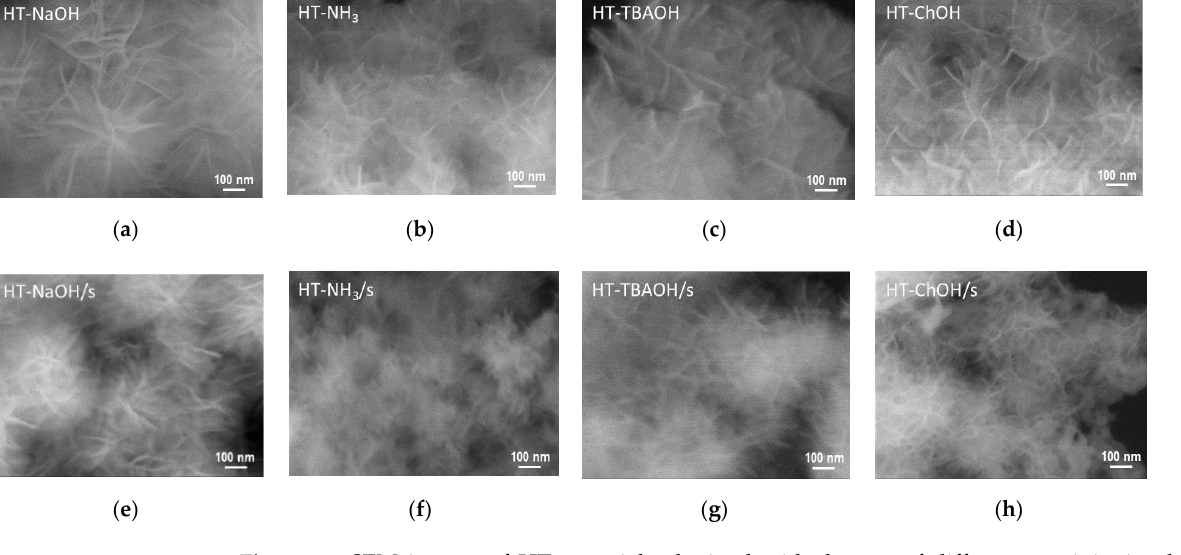
Figure 3. SEM images of HT materials obtained with the use of different precipitating bases in the presence or absence of starch: ( a ) Ht-NaOH; ( b ) Ht-NH 3 ; ( c ) Ht-TBAOH; ( d ) Ht-ChOH; ( e ) Ht- NaOH/s; ( f ) Ht-NH 3 /s; ( g ) HT-TBAOH/s; and ( h ) HT-ChOH/s. Magnification × 100,000.